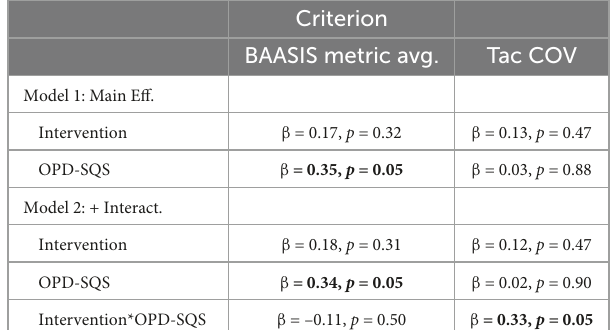
Criterion BAASIS metric